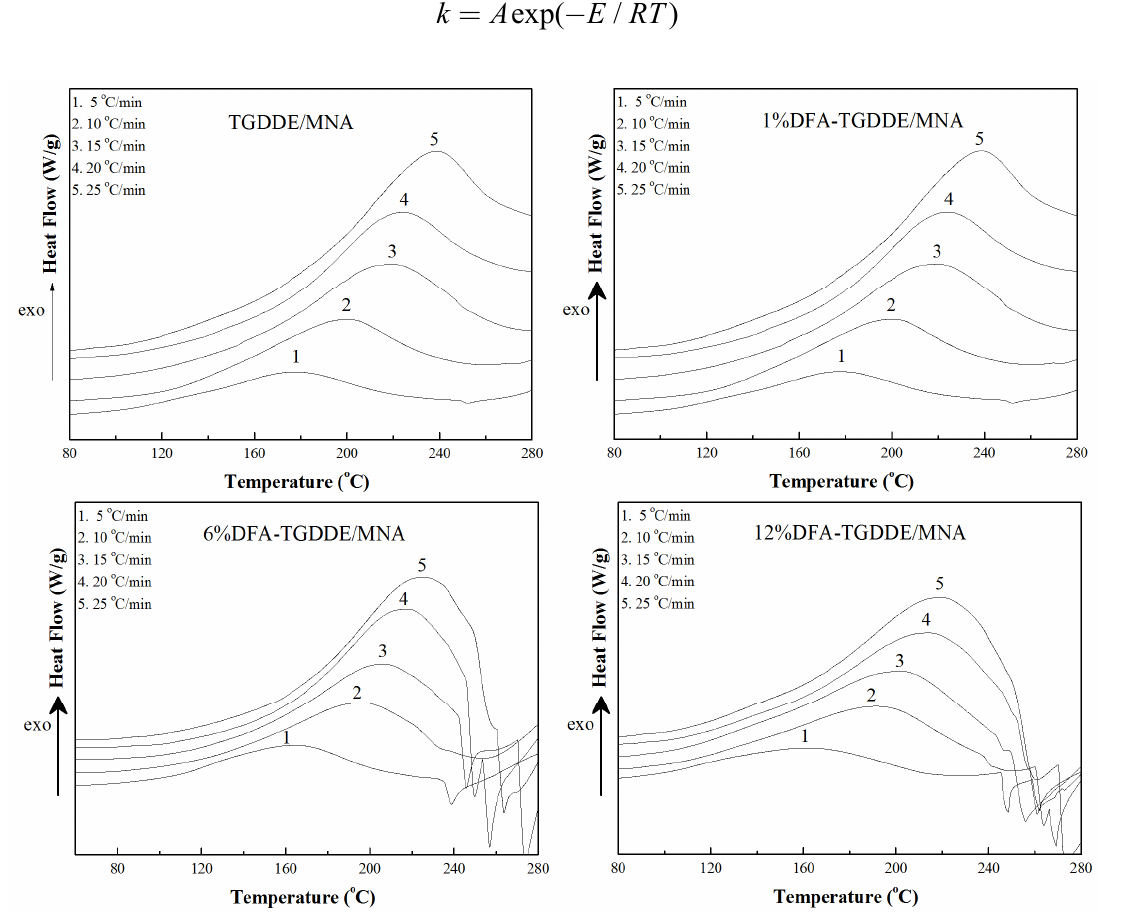
Figure 5. Enthalpy vs. Temperature of the curing process at different curing